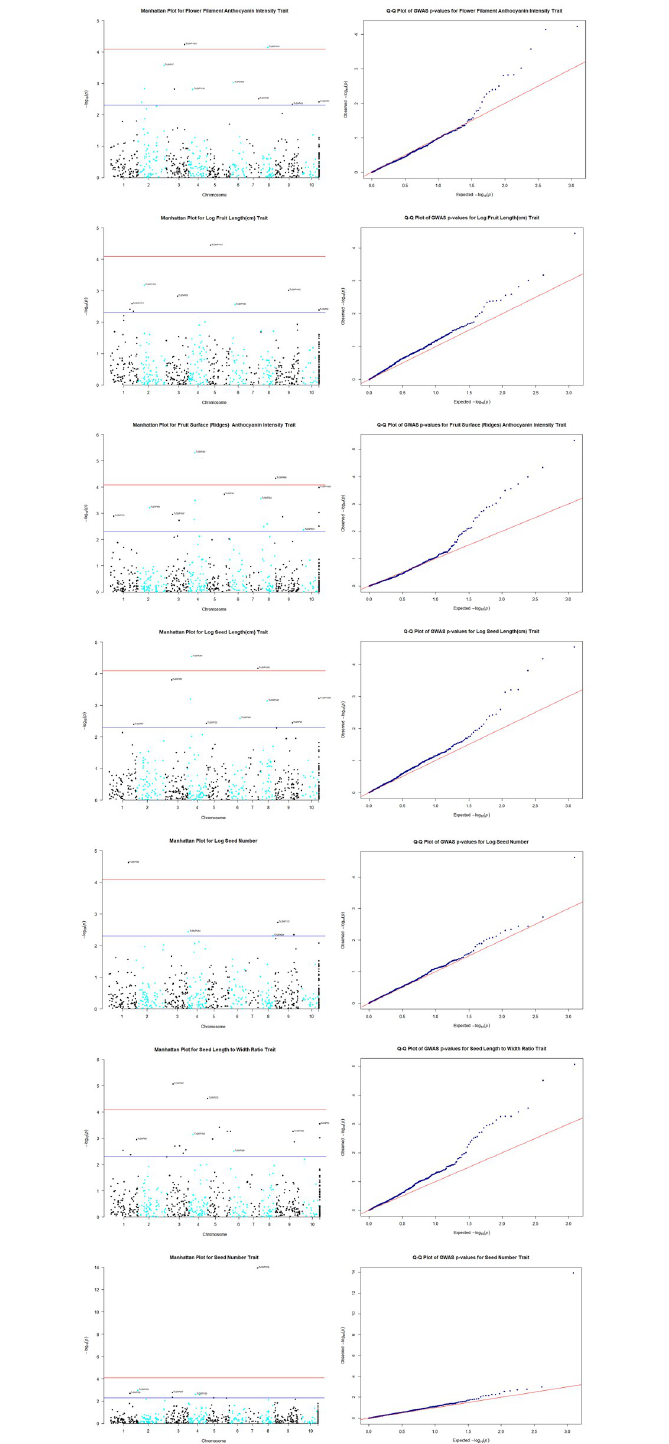
Fig 6. Manhattan plots from genome-wide association analysis. Genome-wide association plots across 8 cacao chromosomes for seven phenotypic traits that had statistically significant MTAs: filament anthocyanin intensity, fruit surface (ridges) anthocyanin intensity, log fruit length, log seed length, log seed number, seed length to width ratio, seed number. • Based on TASSEL version 5.2.50 MLM results for 421 cacao accessions (612 SNPs).